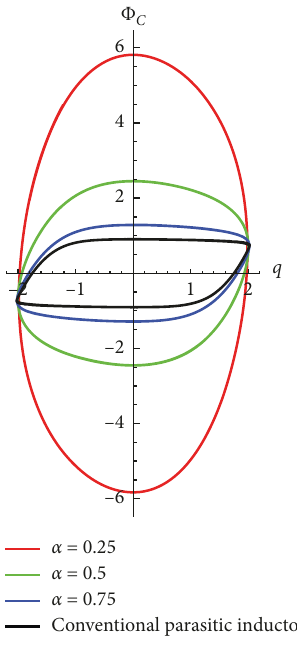
Figure 14: Φ C vs q the memristor-capacitor circuit with the parasitic fractional inductor/conventional parasitic